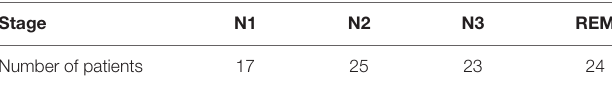
TABLE 1 | Available data in each sleep stage with at least 4 min length. Stage N1 N2 N3 REM Number of patients